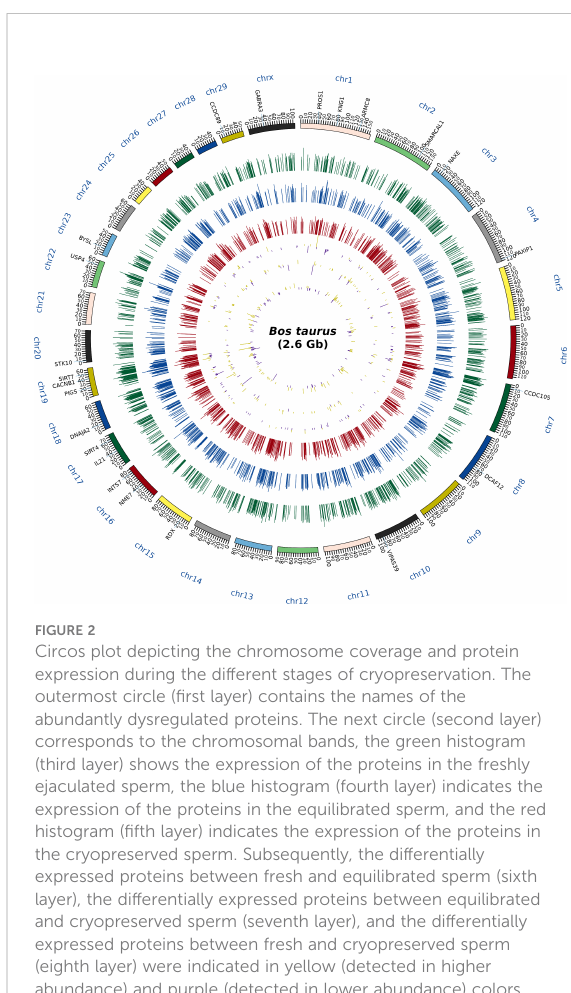
FIGURE 2 Circos plot depicting the chromosome coverage and protein expression during the different stages of cryopreservation. The outermost circle ( fi rst layer) contains the names of the abundantly dysregulated proteins. The next circle (second layer) corresponds to the chromosomal bands, the green histogram (third layer) shows the expression of the proteins in the freshly ejaculated sperm, the blue histogram (fourth layer) indicates the expression of the proteins in the equilibrated sperm, and the red histogram ( fi fth layer) indicates the expression of the proteins in the cryopreserved sperm. Subsequently, the differentially expressed proteins between fresh and equilibrated sperm (sixth layer), the differentially expressed proteins between equilibrated and cryopreserved sperm (seventh layer), and the differentially expressed proteins between fresh and cryopreserved sperm (eighth layer) were indicated in yellow (detected in higher abundance) and purple (detected in lower abundance)